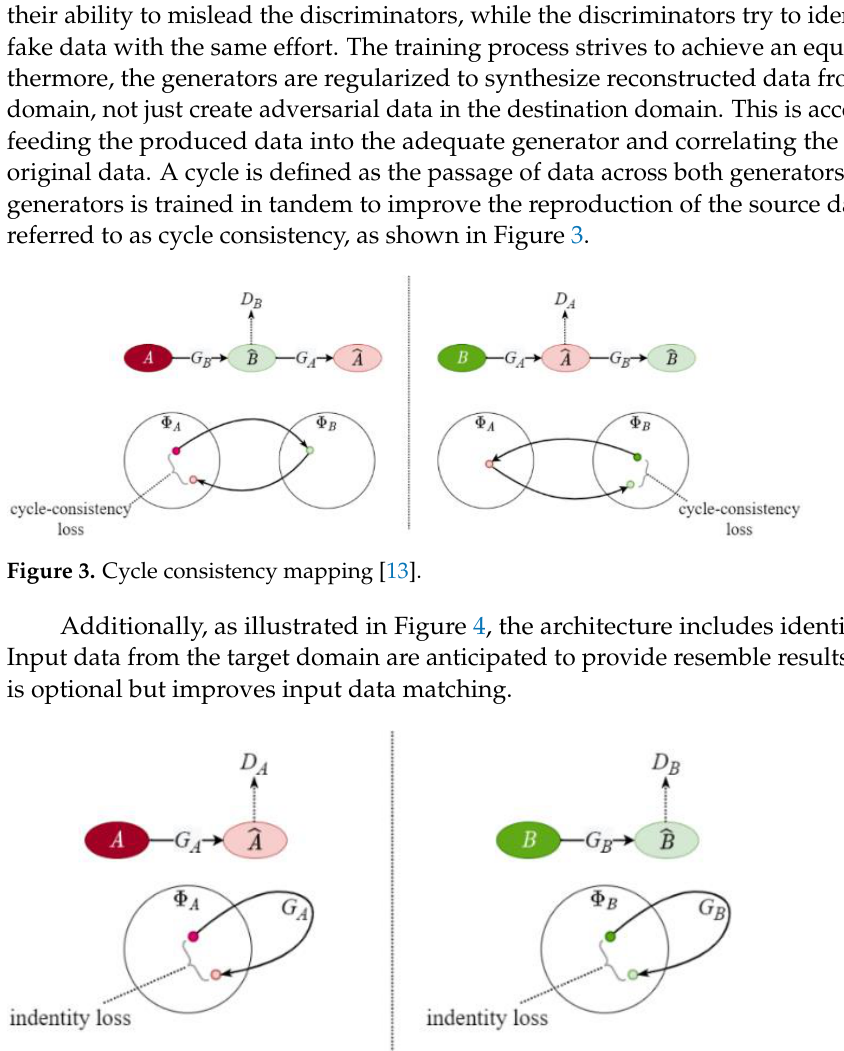
Figure 2. CycleGAN diagram [13].